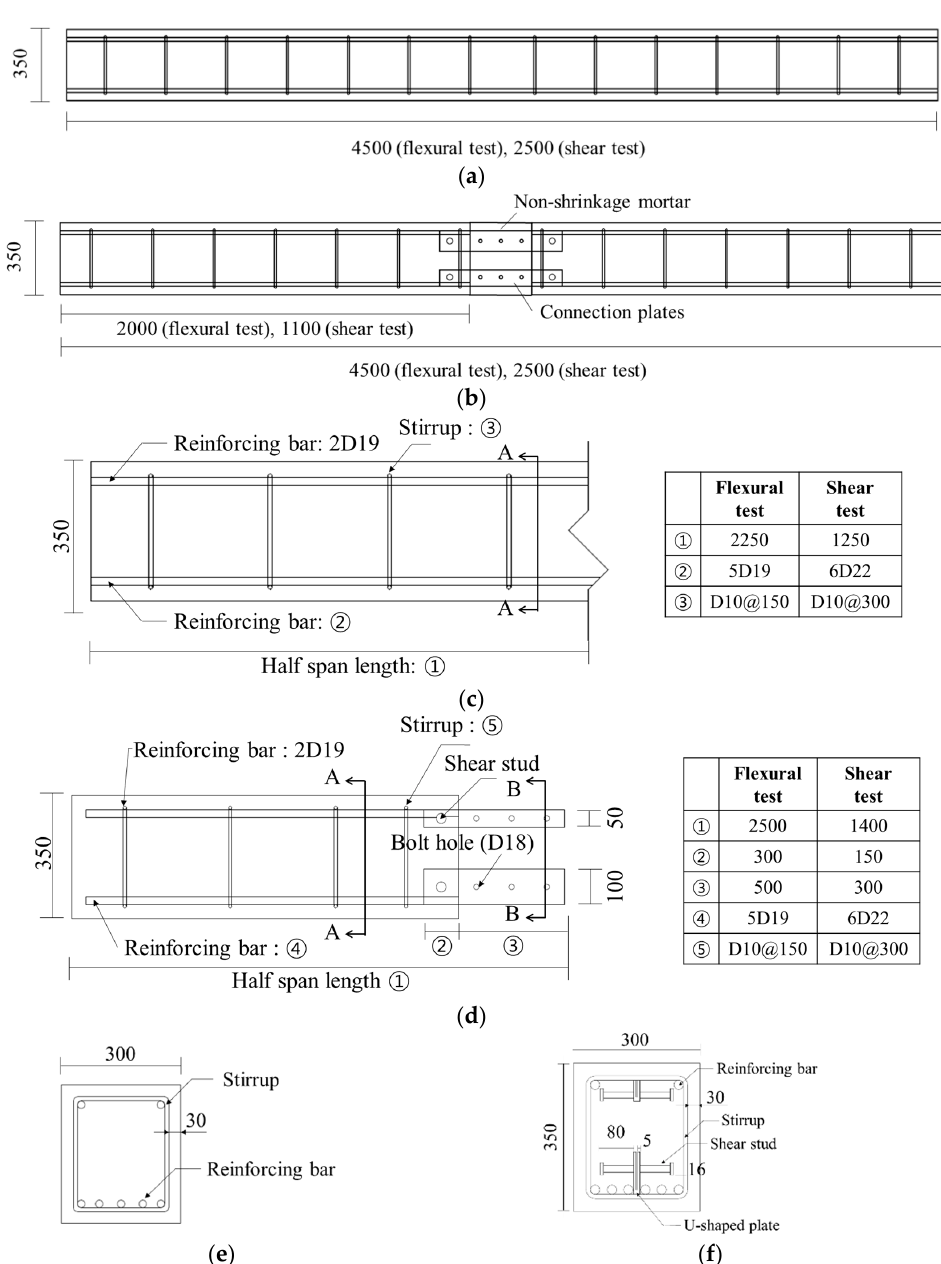
Figure 5. Drawings of the specimens for flexural and shear tests (mm): ( a ) monolithic specimens; ( b ) PC modular specimens; ( c ) sideview of monolithic beam specimens; ( d ) sideview of precast concrete modular specimens; ( e ) A-A section; ( f ) B-B